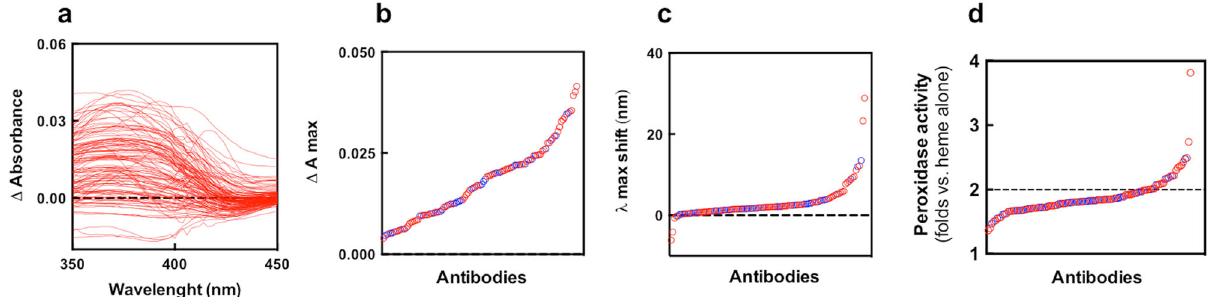
Fig. 2 Binding of heme to Abs in solution. UV – vis absorbance spectroscopy analysis of the interaction of repertoire of therapeutic Abs with hemin. a Differential absorbance spectra in the wavelength range 350 – 450 nm obtained after subtraction of the spectrum of 5 μ M hemin in PBS from the spectrum of 5 μ M hemin in the presence of 670 nM of monoclonal IgG1. Each line depicts the differential spectrum of an individual Ab. b Plot showing the maximal increase of the absorbance intensity of heme in the presence of therapeutic Ab. c Plot of the value of the shift of the maximal wavelength in the presence of antibody as compared to the absorbance maxima of heme in PBS only. On panels b and c , each circle depicts the absorbance maximal intensity or shift in the wavelength maxima of individual Ab. d Changes of catalytic activity of heme upon interaction with Abs. The oxidation of ABTS was used as a colorimetric reaction for the assessment of the catalytic activity of heme in the absence and presence of monoclonal IgG1. The panel illustrates the fold change in the peroxidase activity, as compared to heme alone in PBS, for the repertoire of therapeutic Abs. Each circle depicts the average changes in the peroxidase activity of an individual monoclonal Ab from duplicate readings. The dashed line indicates a twofold increase in the catalytic activity of heme in the presence of Abs as compared to heme alone. On panels a , c , and d the red circles represent Abs that are currently in clinical trials. The blue circles indicate the clinically approved